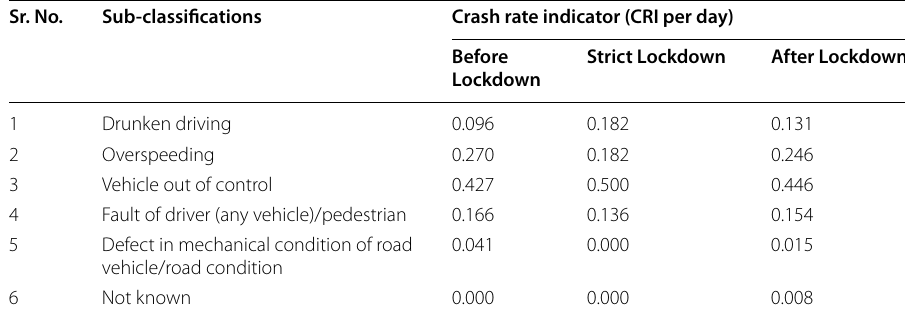
Table 5 CRI by causes Sr.